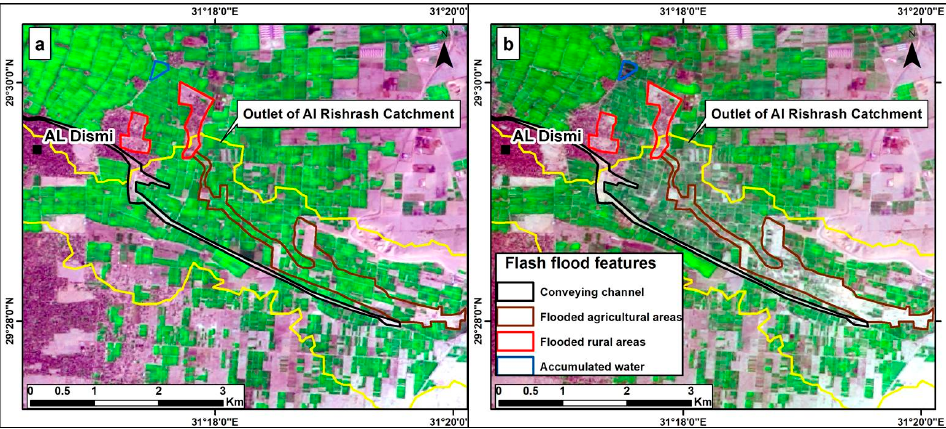
Figure 9. Multi-temporal Landsat 8 image close-up on the outlet of Wadi Al Rishrash catchment before ( a ) and after ( b ) the flash-flood event of 13 March 2020 showing the overflooding of the conveying channel, drowning of the agricultural lands, flooding of villages and urban areas and accumulation of water ponds.